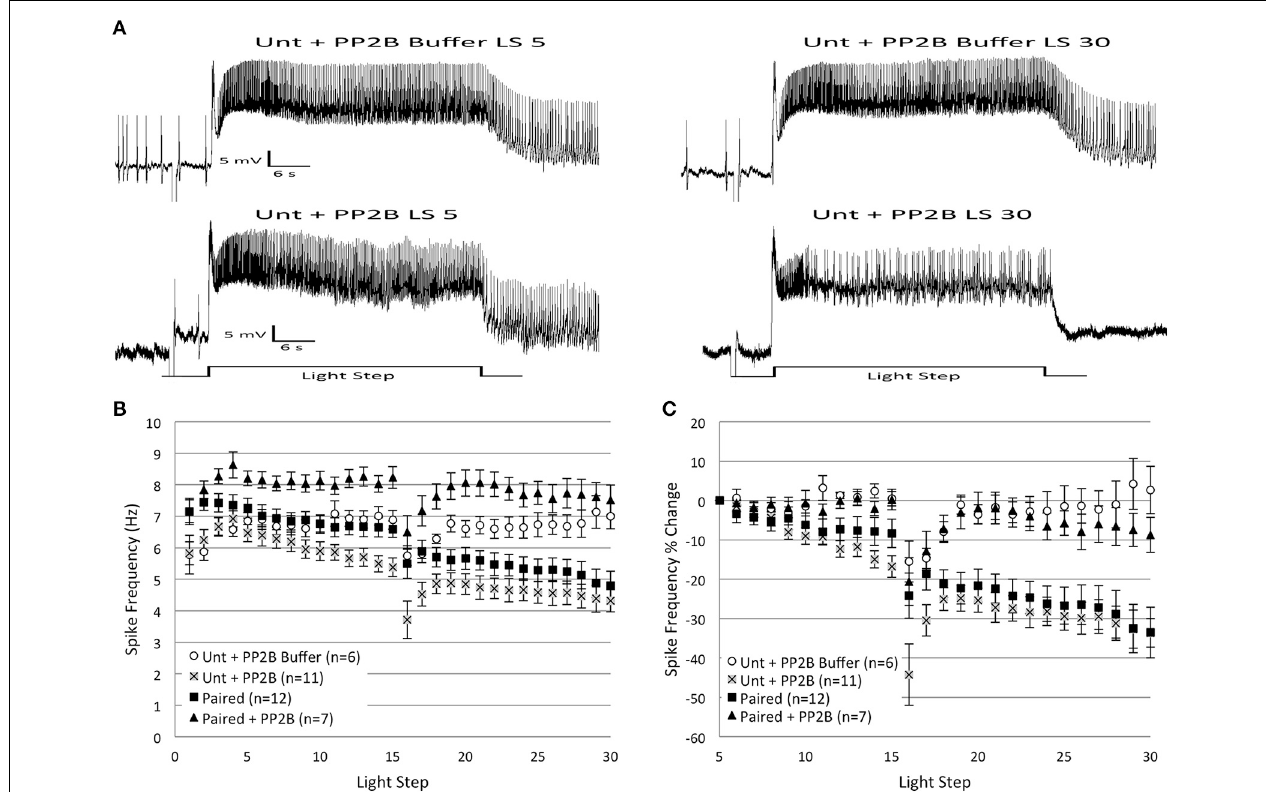
FIGURE 7 | Injection of catalytically active protein phosphatase 2B (caPP2B) into Paired Type B cells prevented the decrease in light-evoked spike frequency produced by repeated LSs, and reduced spike frequencies when injected into Untrained cells. (A) Representative light responses recorded from an Untrained B cell injected with PP2B buffer ( Unt + PP2B Buffer ; top trace) or caPP2B ( Unt + PP2B ; bottom trace). The Unt + Buffer control cell showed no change in spike frequency from the 5th to 30th LS, while the Unt + PP2B cell showed a progressive decrease in spike frequency that mimicked the decreases observed during in vitro extinction in Paired (no drug) cells. (B) Summary spike frequency data across 30 LSs for Type B cells exposed to buffer or caPP2B. Paired + PP2B cells did not show decreases in spike frequency and spiked at levels not statistically